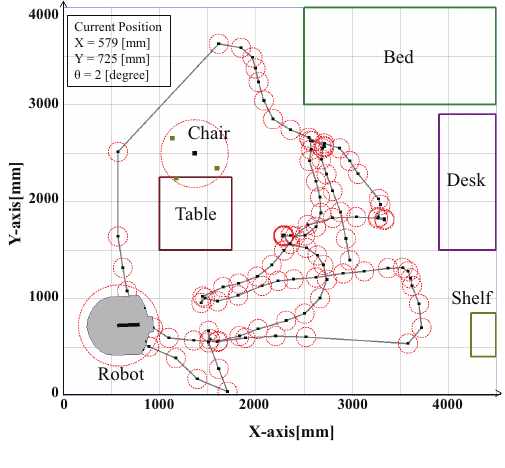
Figure 13. Trajectory of robot